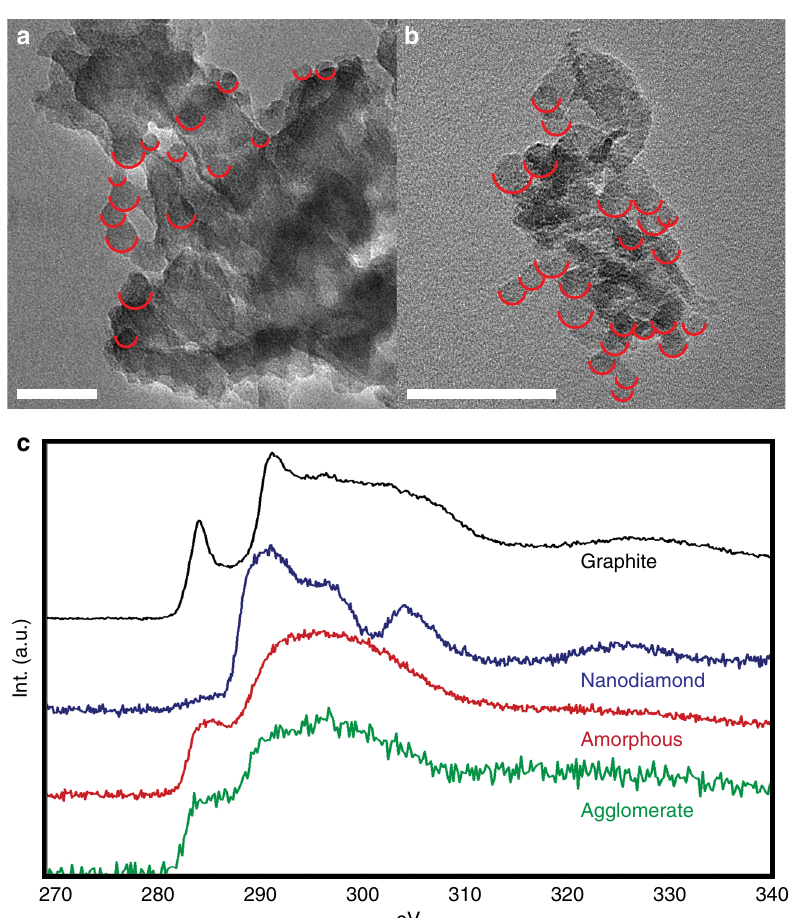
Fig. 3 TEM characterization of recovered carbon agglomerates. a , b Images of carbon nanoparticle agglomerates containing globular domains recovered from the inside of the sample cavity after LCO evaporation. Semicircles are placed as an aid to identify domains, while (in the top half of the semicircle) not obscuring edges. Measured domain sizes range from 5 to 30 nanometers. Supplementary Fig. 5 shows a comparison of the above images with and without markings. c Carbon K edge EELS spectra from the carbon agglomerate and reference carbon materials (here, amorphous corresponds to the lacey carbon of TEM grids); agglomerate spectrum matches well that of amorphous carbon. Scale bars are 50 nm. Source data are provided as a Source Data fi